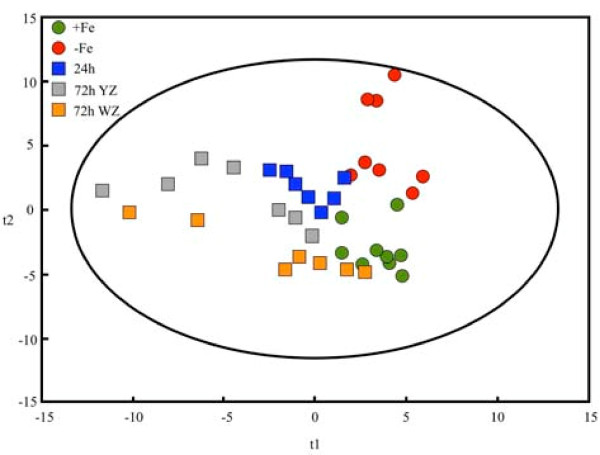
Score scatter plot of identified metabolites. Partial Least Square (PLS) analysis, showing the score scatter plot of PLS vector 1 (t1) vs. PLS vector 2 (t2) of identified metabolites in sugar beet root tips from Fe sufficient (+Fe, green circles), Fe-deficient (-Fe, red circles), 24 h Fe-resupplied (24h, blue squares), 72 h Fe-resupplied YZ (72h YZ, grey squares) and 72 h Fe-resupplied WZ (72h WZ, orange squares).